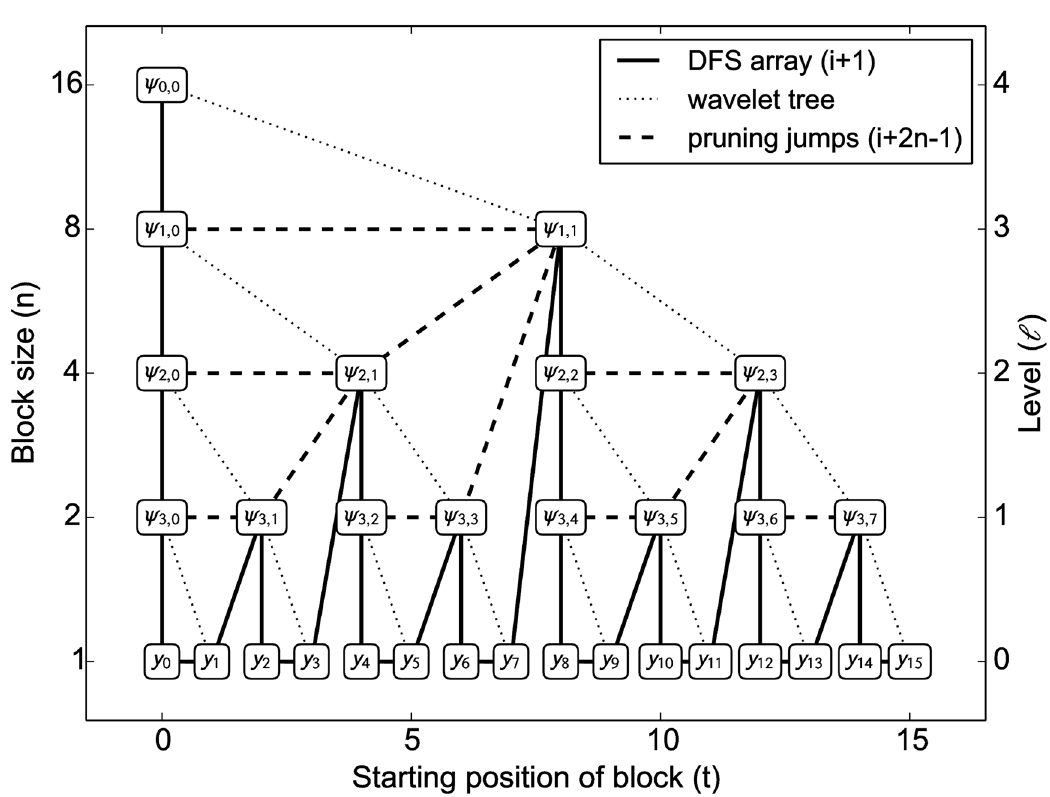
Fig 7. Mapping of wavelets ψ j , k and data points y t to tree nodes N ℓ , t . Each node is the root of a subtree with n = 2 ℓ leaves; pruning that subtree yields a block of size n , starting at position t . For instance, the node N 1,6 is located at position 13 of the DFS array (solid line), and corresponds to the wavelet ψ 3,3 . A block of size n = 2 can be created by pruning the subtree, which amounts to advancing by 2 n − 1 = 3 positions (dashed line), yielding N 3,8 at position 16, which is the wavelet ψ 1,1 . Thus the number of steps for creating blocks per iteration is at most the number of nodes in the tree, and thus strictly smaller than 2 T .